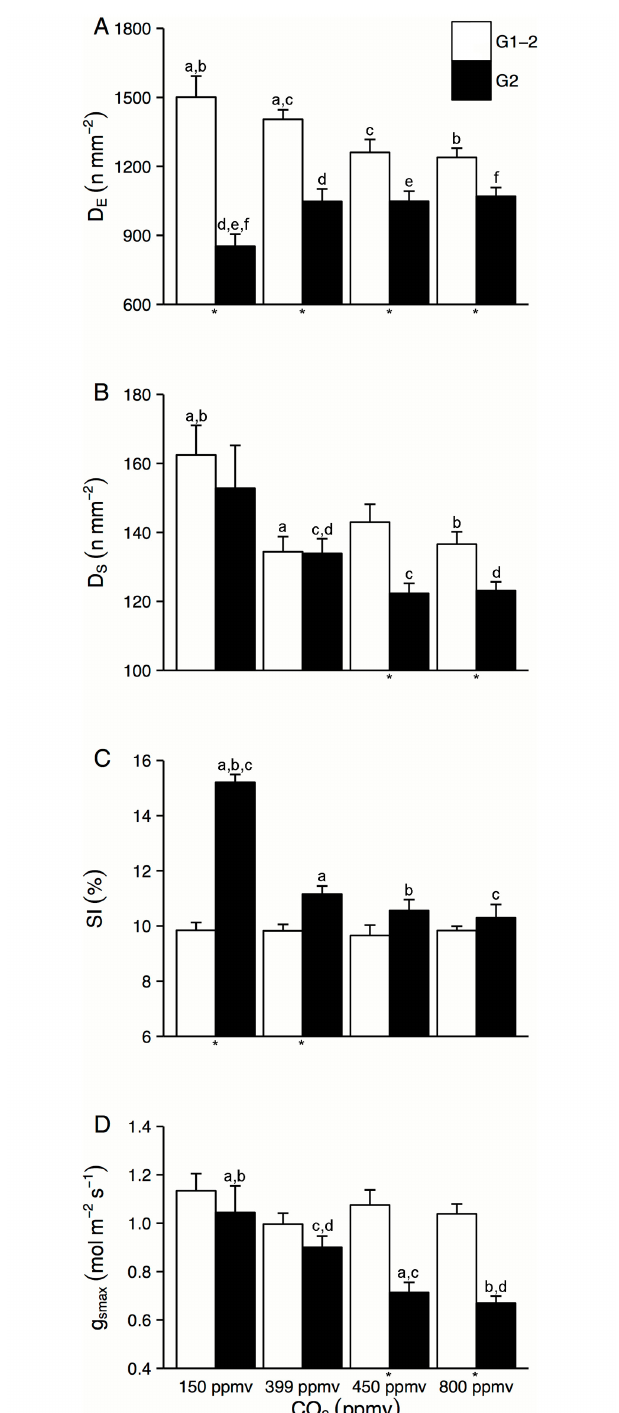
Fig 2. Response of structural stomatal parameters to CO 2 in G1-2 and G2. (A) D E decreased with CO 2 in G1-2. In G2, D E is lower at 150 ppmv than in other CO 2 treatments. (B) D S responded slightly to CO 2 in G1-2 and shows a levelling-off of the response between 399 – 450 ppmv in G2. (C) SI did not respond to CO 2 in G1- 2. In G2, the SI response at 150 ppmv was significant with a levelling-off of response around 399 ppmv. (D) The g smax did not respond to CO 2 in G1-2. In G2, g smax is highest at 150 ppmv, then decreased stepwise with CO 2 until 450 ppmv, where the response levelled off. Error bars represent standard error of the